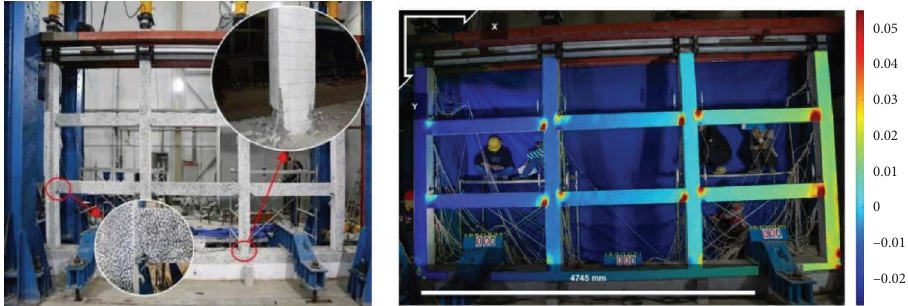
Figure 4: /e failure mode.